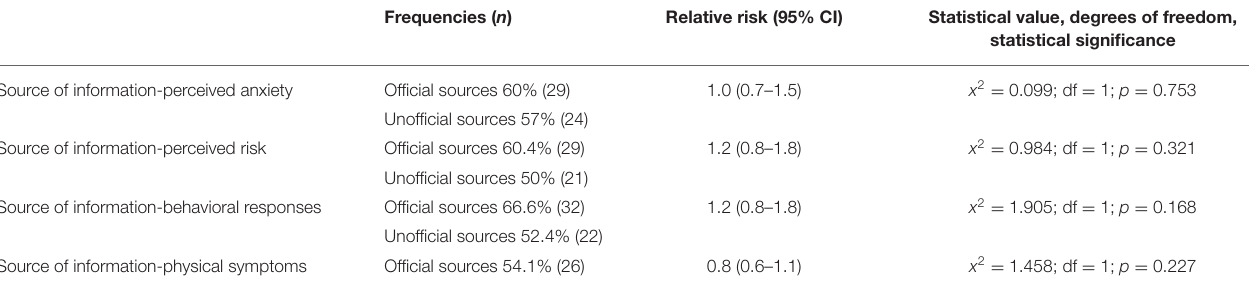
TABLE 4 | Bivariate analysis between information sources and anxiety, perceived risk, physical symptoms, and behavioral